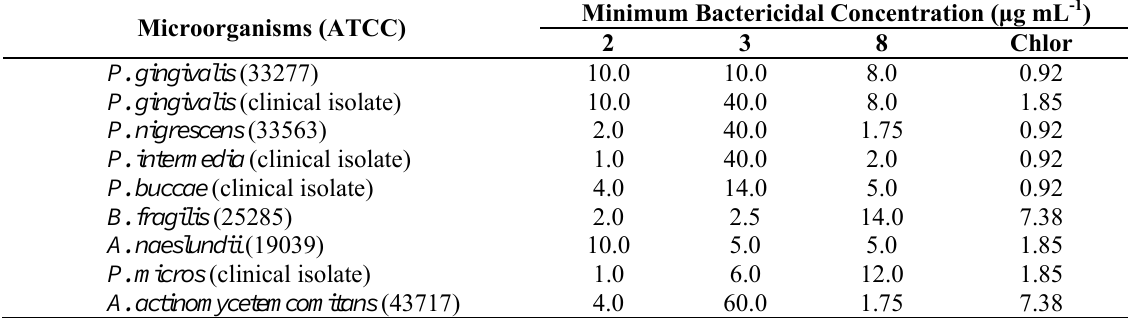
Table 2. Minimum bactericidal concentration for the compounds 2 , 3 and 8 against endodontic